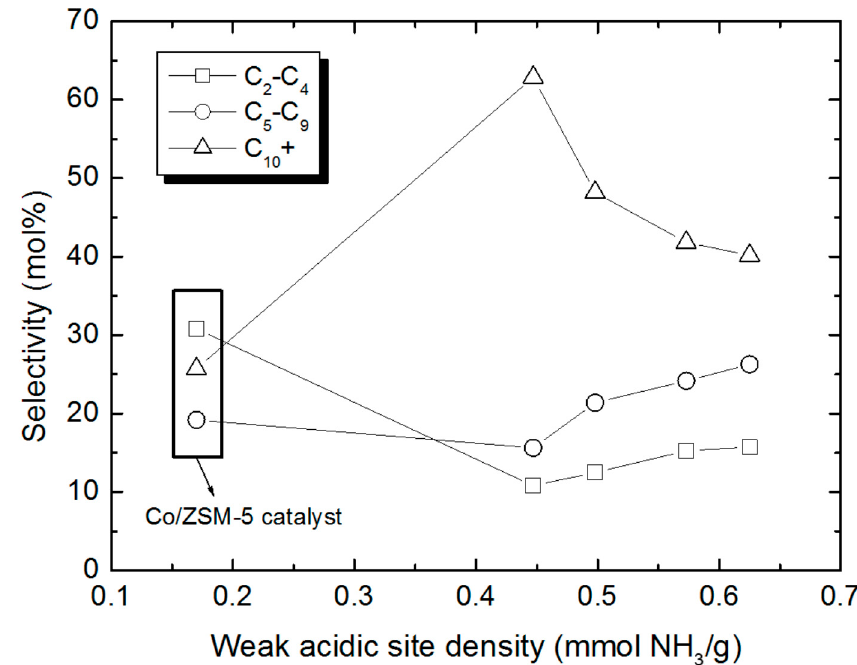
Figure 28. Effect of Promoter on the correlation between the surface activity and the selectivity of hydrocarbons. Reprinted with permission from [118].